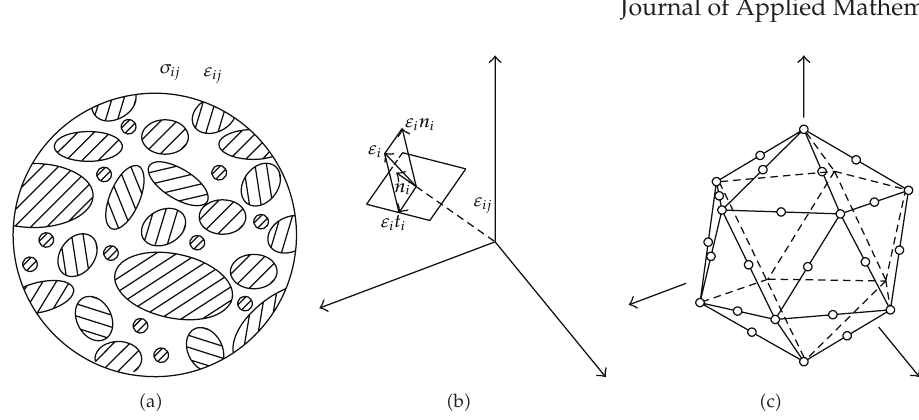
Figure 4: (cid:5) a (cid:6) The representative volume of concrete, (cid:5) b (cid:6) projection of strain tensor, and (cid:5) c (cid:6) three- dimensional polygon for the stress integration in the microplane constitutive model.